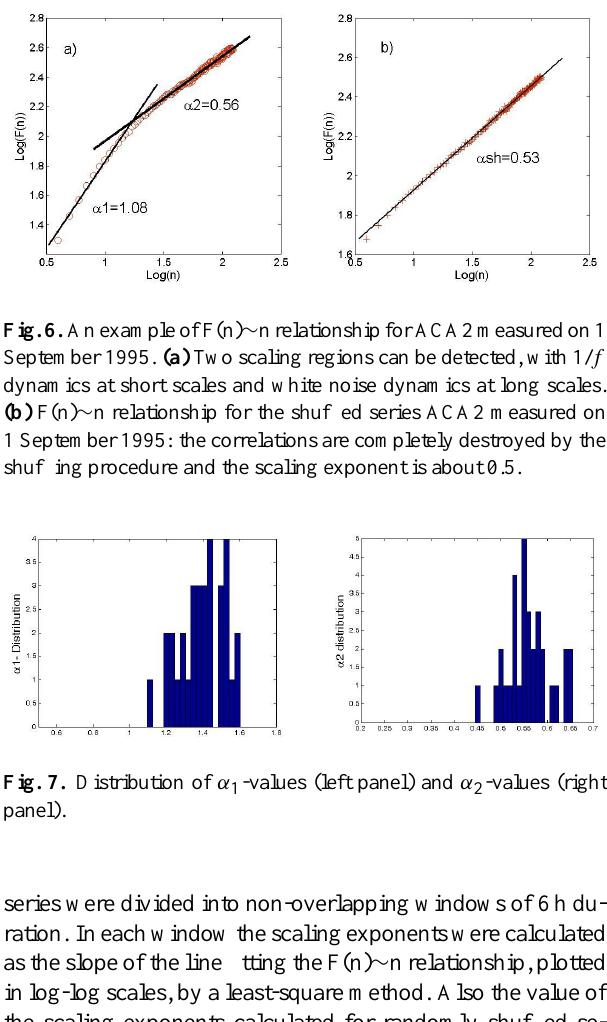
Figure 8. Power spectrum calculated in the NTD.